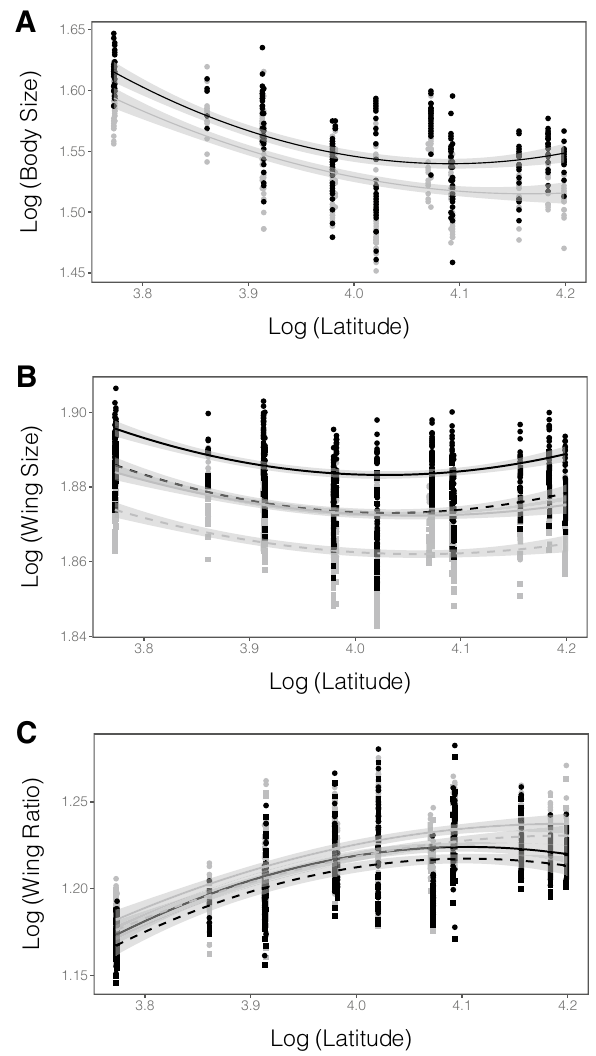
Figure 2. ( A ) Latitudinal variation of body size in Lestes sponsa (measured as head width, mm) for females (black) and males (gray). ( B ) Latitudinal variation of wing centroid size (derived from landmark coordinates in pixels) for females and males, including fore- and hindwings. ( C ) Latitudinal variation of wing ratio (ratio between wing centroid size and body size) for fore- and hindwings of females and males. (female forewings: black circles and solid line; female hindwings: black squares and dashed line; male forewings: gray circles and solid line; male hindwings: gray squares and dashed line; the shade around the regression lines shows the 95%